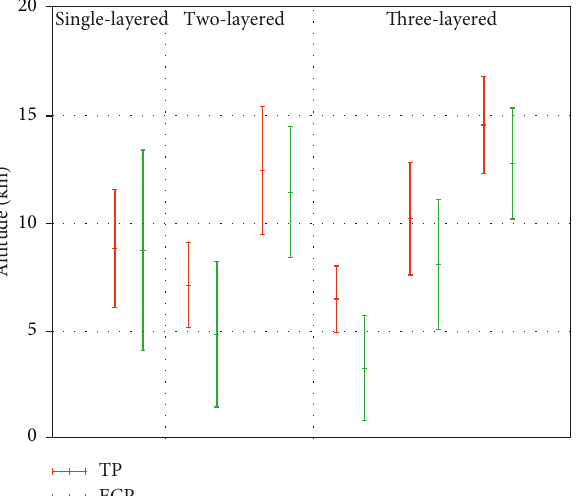
Figure 9: Mean top height of the cloud layers of (a) single-layered, (b) two-layered, and (c) three-layered clouds. The error bars represent standard errors of the means. Table 2: Average thickness of cloud layers of single-layered and multilayered clouds (km).